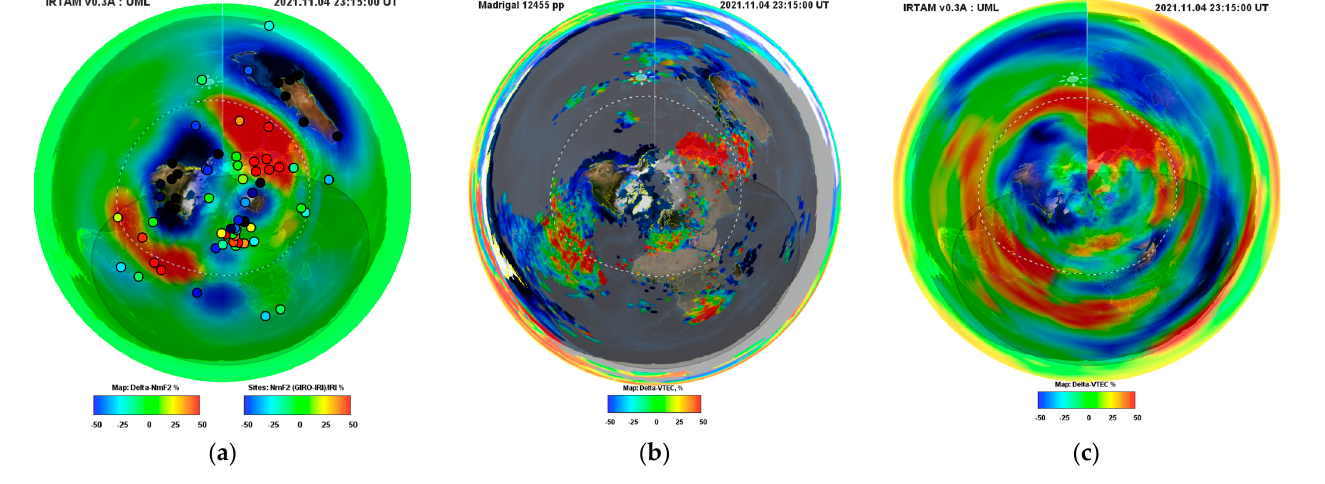
Figure 4. Weather − minus − climate percent anomaly maps showing plasma density depression on November 4, 2021, 23:15 UT as seen by GIRO and GNSS. ( a ) GIRO ∆ NmF2 map, 7.5 − min latency, and 69 sites. ( b ) Madrigal ∆ VTEC, several days latency, and 4911 sites. ( c ) UPC Rapid ∆ VTEC map, 2 h latency, 5 min soon, and 250 sites. The dashed line is the magnetic equator, and the shaded area corresponds to nighttime.